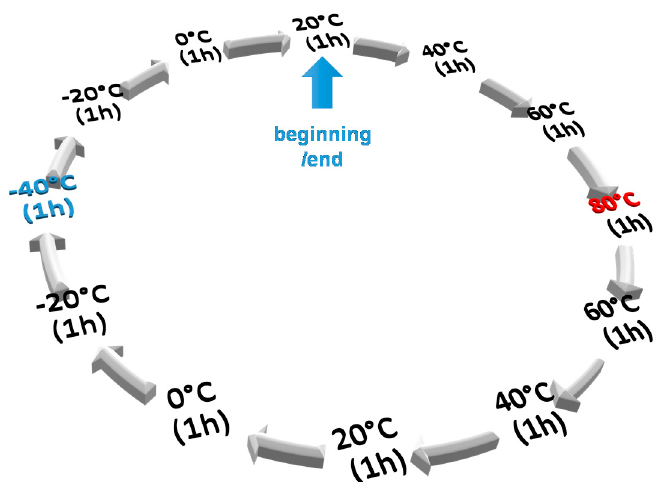
Figure 18. Thermal cycling performed on a 10 cm × 10 cm TiO 2 –SiO 2 grid architecture divided into three steps: a first increase from 20 °C to 80 °C followed by a decrease down to − 40 °C, while the last increase is performed to reach 20 °C. Each temperature level lasts 1 h.